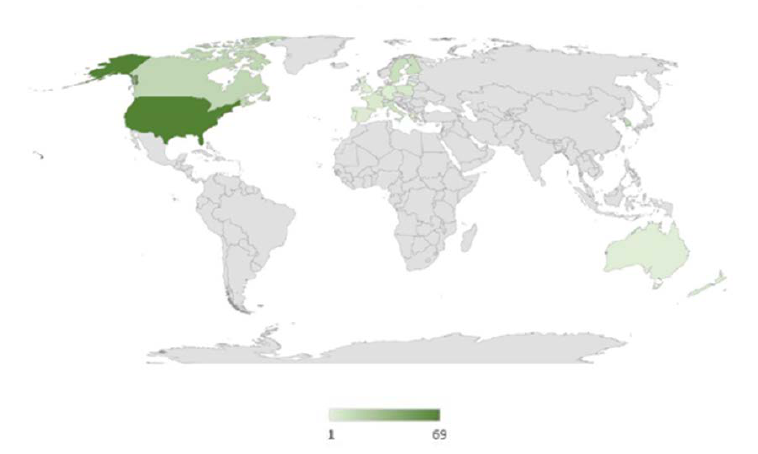
Figure 8. Studies on MSD in agriculture (1995–2020). Developed